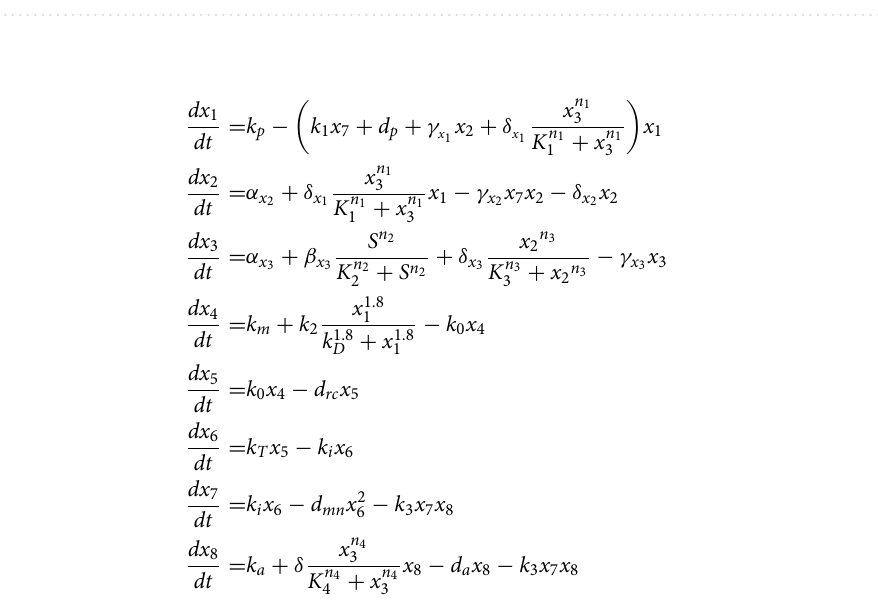
Table 1. Parameters values, and